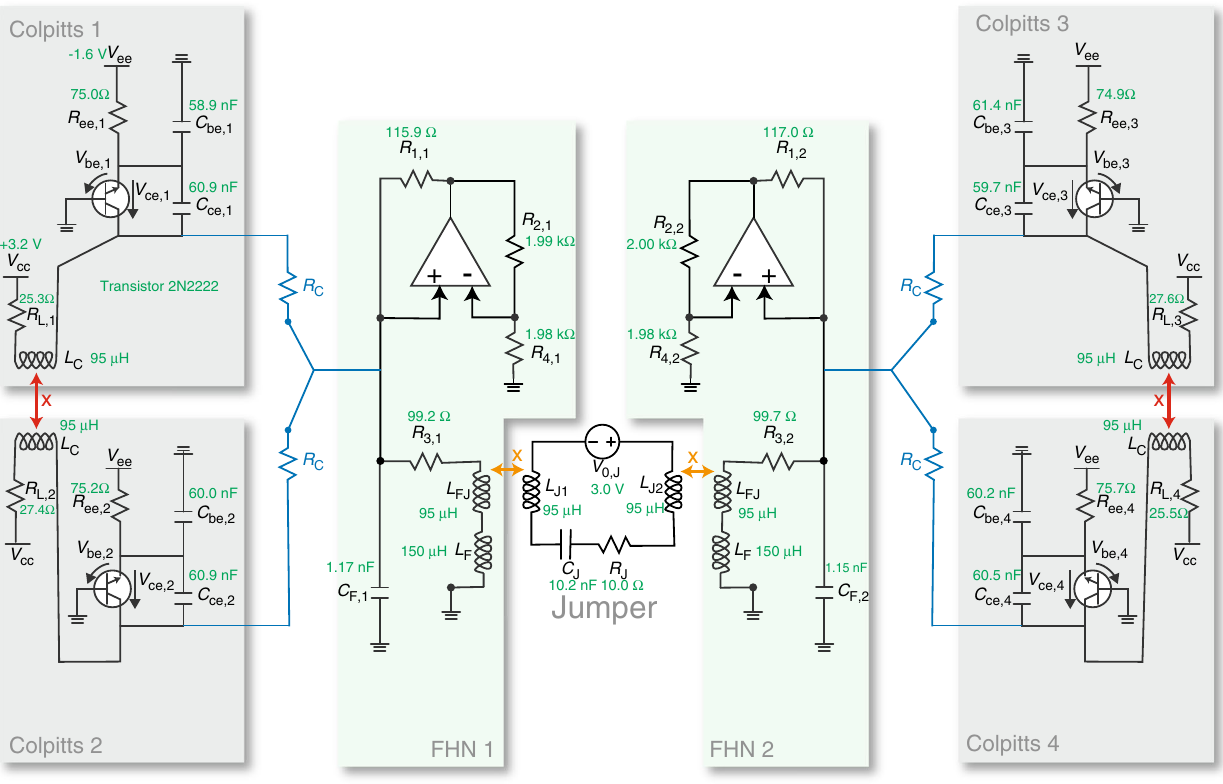
Fig. 3 Schematic of the experimental setup. R C = 2.2 k Ω . We vary the magnetic coupling between Colpitts 1 and 2 and Colpitts 3 and 4, k C , from − 0.4 to 0.4 by varying separation × (red). We hold the separation between the FHNs and the jumper (× in orange) constant such that the coef fi cient of mutual inductance, k FJ , is maintained equal to 0.35.